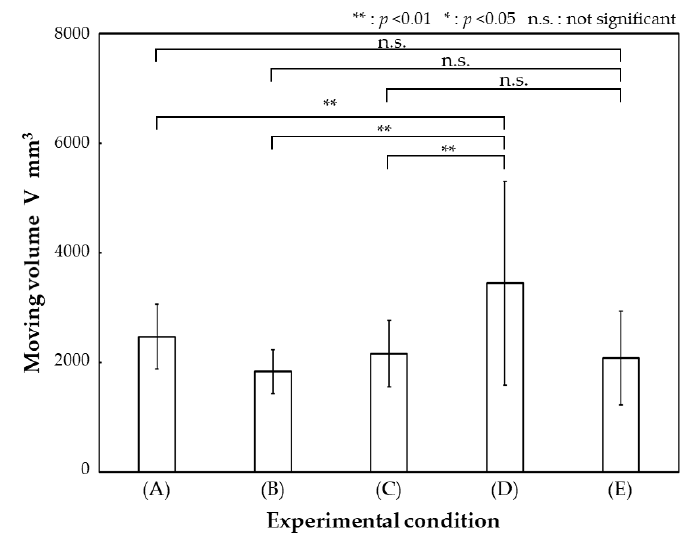
Figure 7. Result of moving volume.